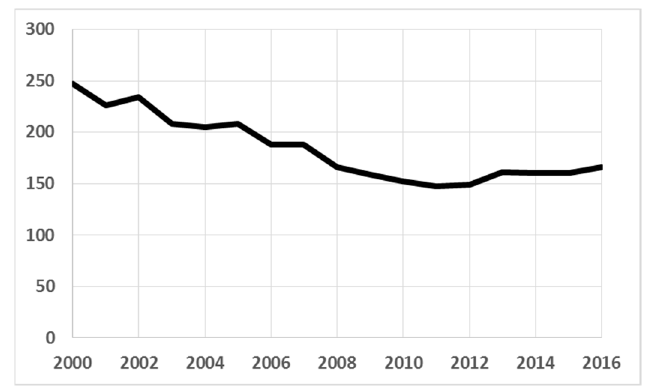
Figure 1. Residential water use in Melbourne, 2000–2016. X -axis: years. Y -axis: Per-capita residential water use in liters per person per day. Sourced from Melbourne Water [74].